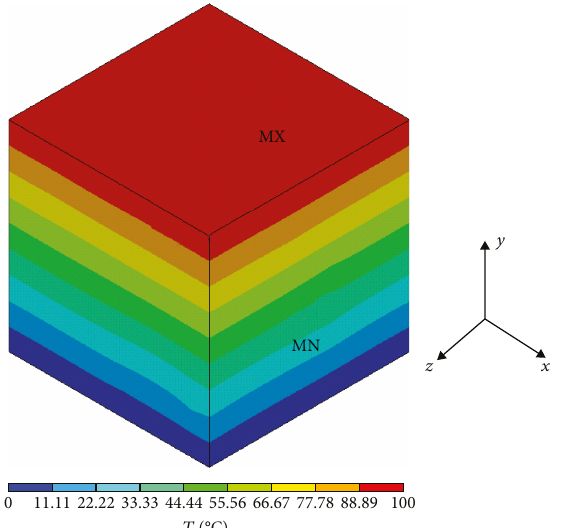
Figure 30: Temperature distribution of the fi ber scale model of the wrapper.